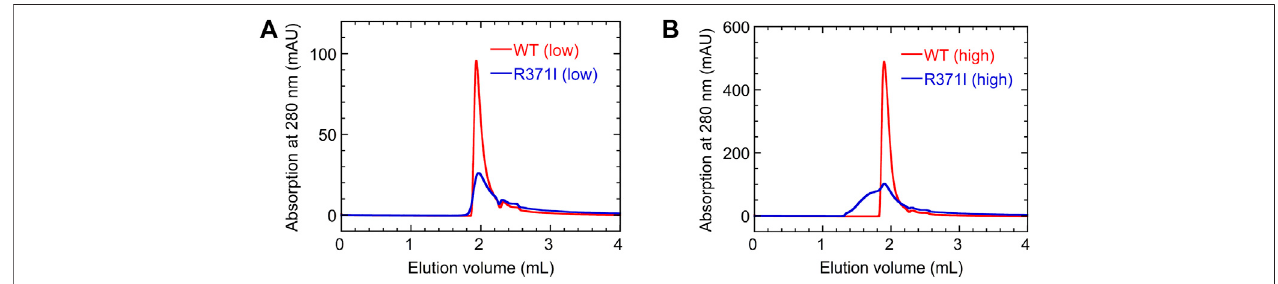
FIGURE 7 | SEC measurements. (A,B) Elution pro fi les of the wild type (red) and R371I mutant (blue) of Int8 measured at low (~100 μ M) (A) and high (~500 μ M) protein concentrations (B) .